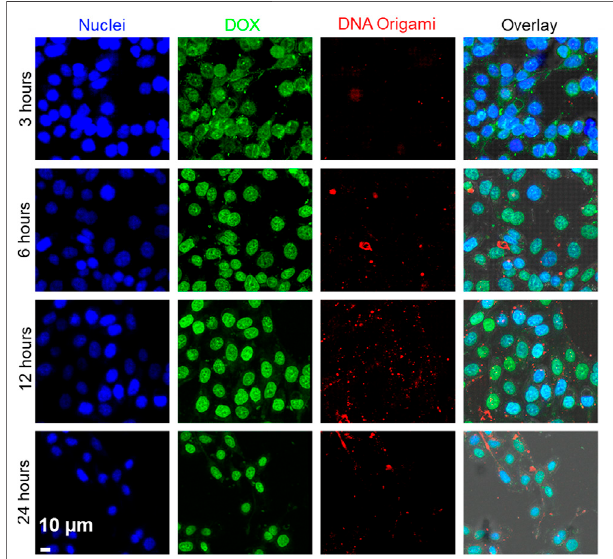
FIGURE 6 | Time-dependent delivery of DOX to the MDA-MB-468 cells. DOX fl uorescenceisshownasgreen,andDNAorigami fl uorescenceisshown as red. Images showed that at 3 h, DOX was localized in the cytoplasm. With increasing time (6 – 24 h), DOX was released from DNA origami and translocatedtothenuclei.CellnucleiwasstainedwithHoechst ® 33342(blue). Scale bar: 10 µm.